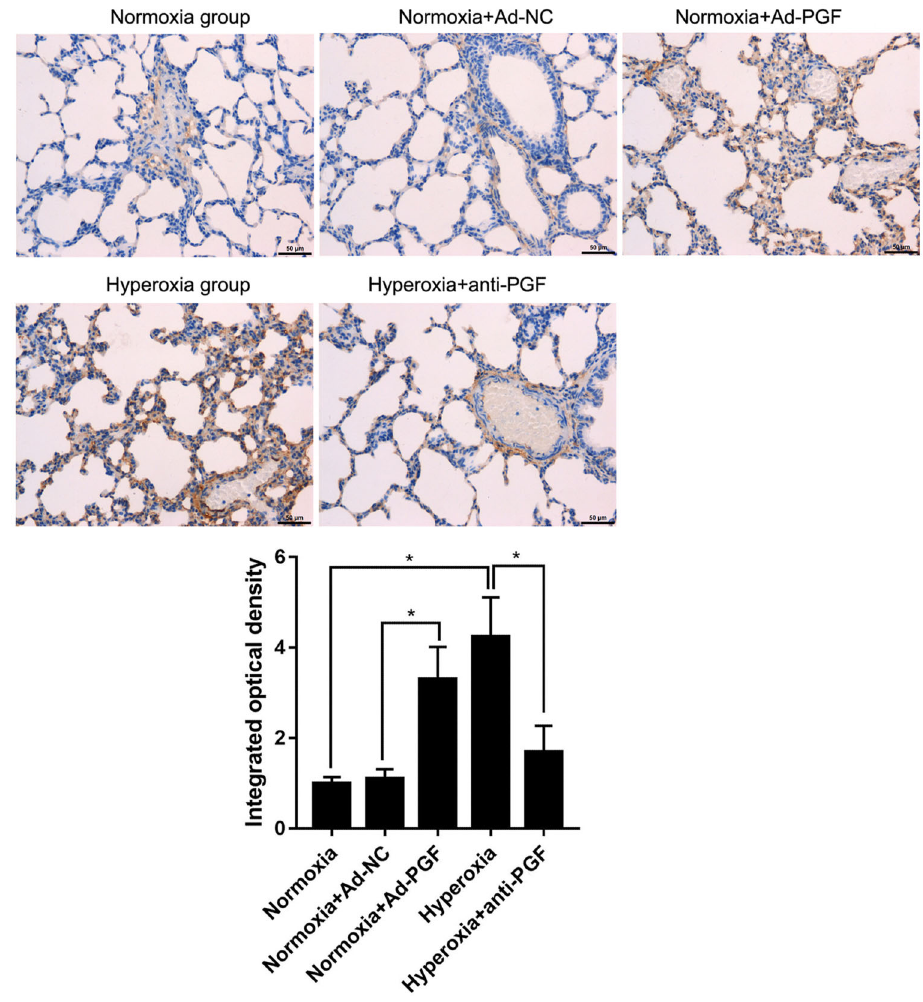
Figure 7. CD34 expression detected by immunohistochemistry in lung tissues from newborn rats of each indicated group (n=10) quanti fi ed using the Image-Pro Plus 6.0 software. Magni fi cation: 200 (cid:1) ; scale bar: 50 m m. The integrated optical density of the Normoxia group was arbitrarily set as 1. Data are reported as means ± SD. *P o 0.05 (ANOVA). PGF: placental growth factor; Ad-NC: adenovirus- negative control; Ad-PGF: adenovirus-placental growth